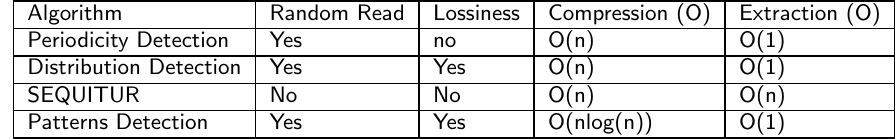
there exist a high amount of patterns within data memory ad- dresses for the instructions in the evaluation set. It also shows that the distribution compression allows for a high compression ratio for random data.